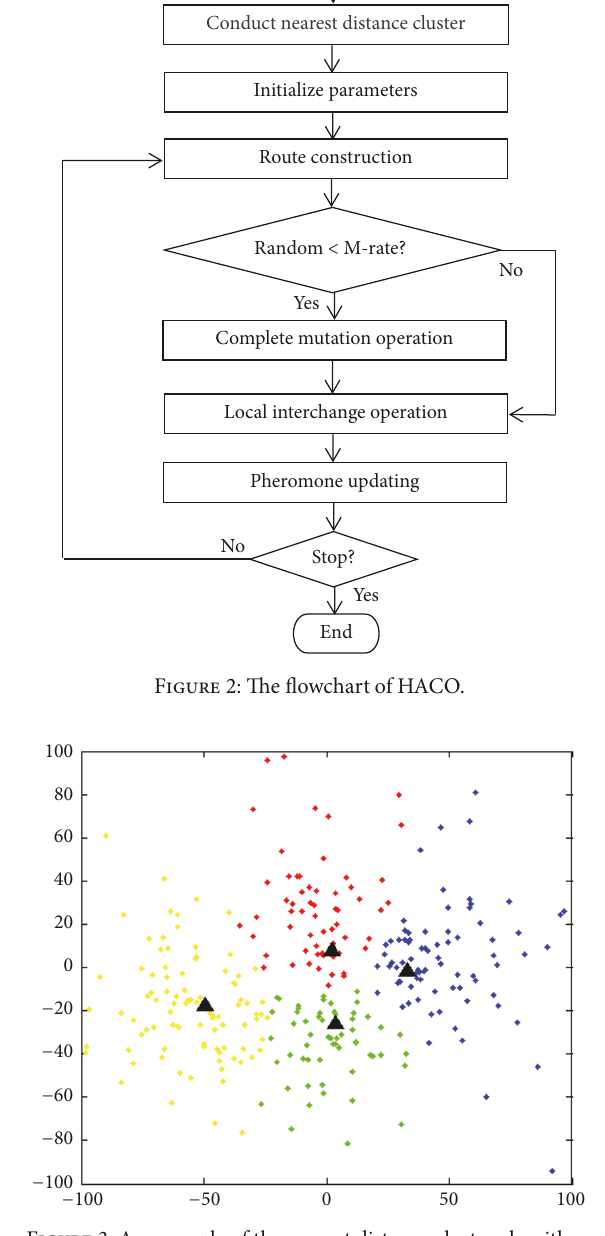
Figure 3: An example of the nearest distance cluster